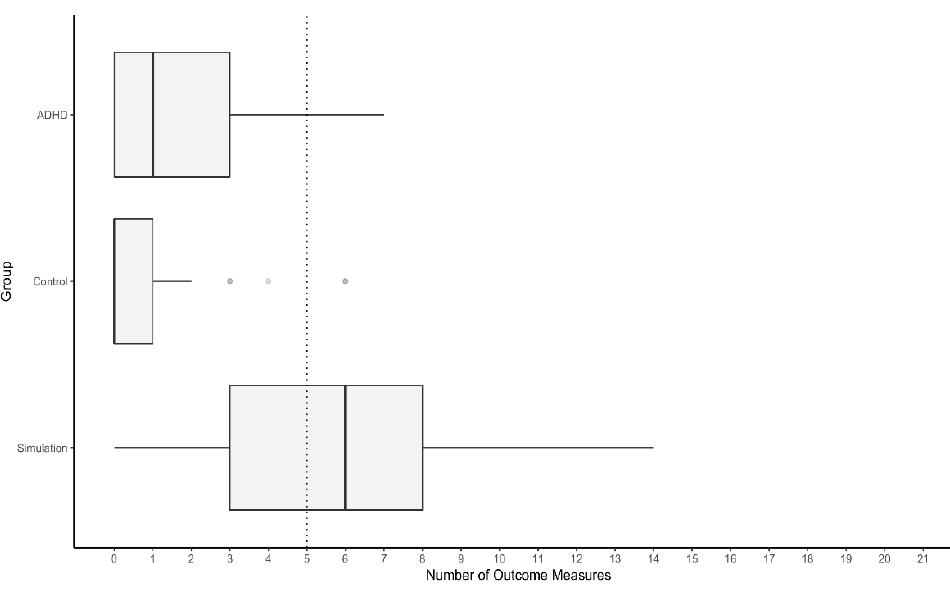
Figure 2. Distribution of the number of outcome measures in the suspect range. Note. The dashed line indicates the number of suspect test results that misclassify less than 10% of the ADHD Group as noncredible.